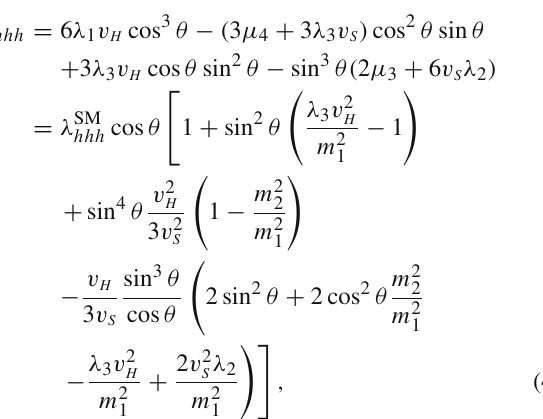
Table 1 List of new scalars (cid:3) inducing a tree-level modification of the triple-Higgs coupling via the tadpole operator O